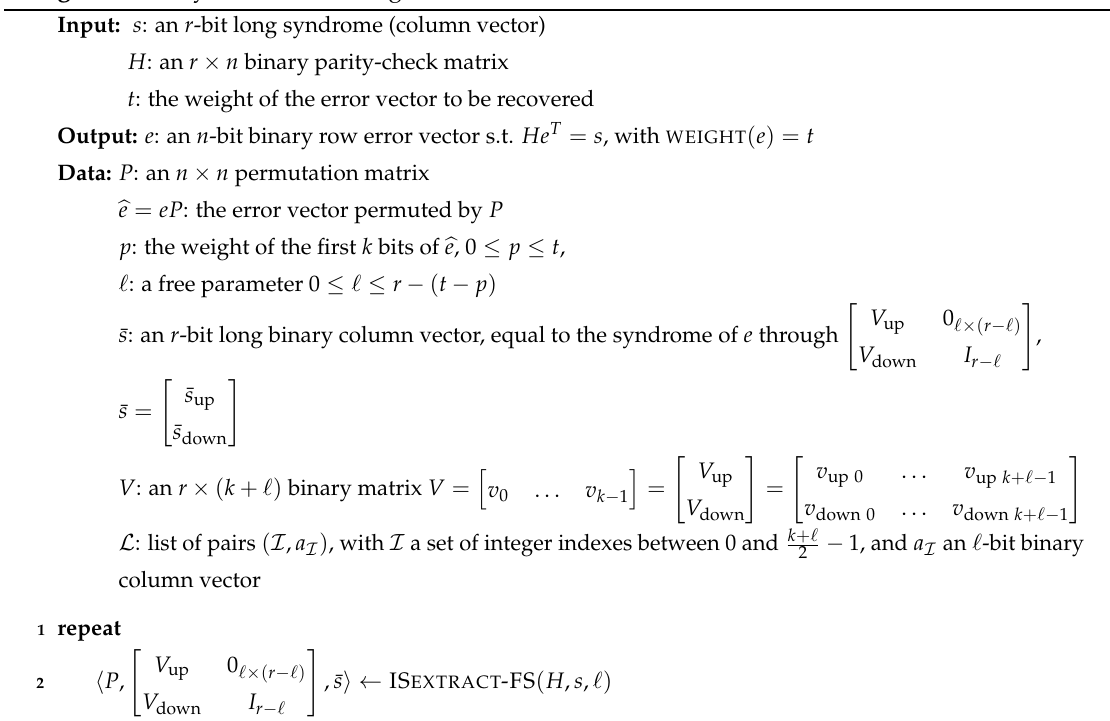
Algorithm 6: Syndrome decoding formulation of Finiasz–Sendrier